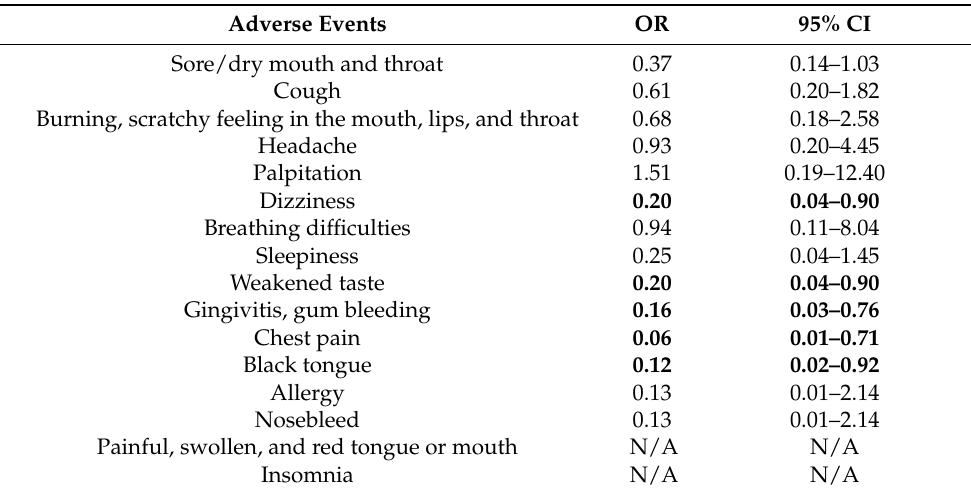
Table 3. Adverse events compared by nicotine-free and nicotine-containing e-liquid use among current daily